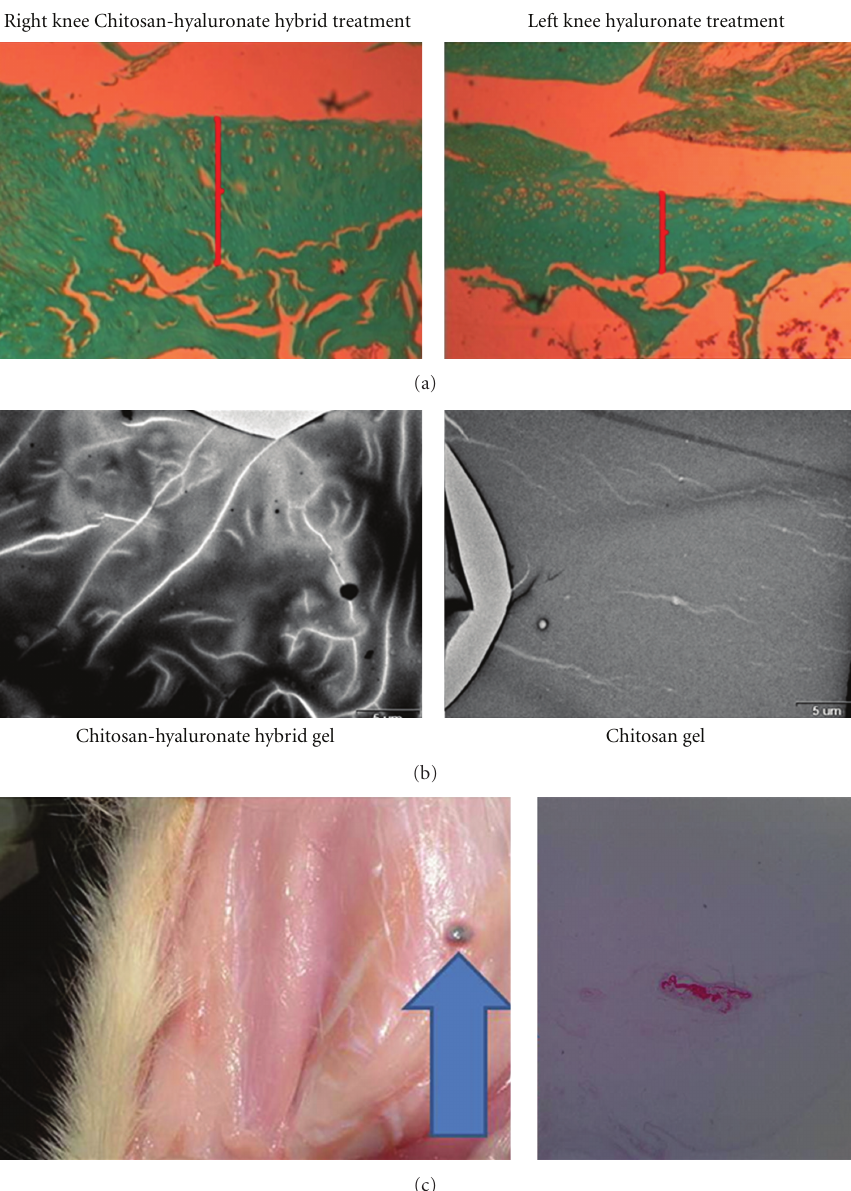
Figure 1: (a) rat knees following medial meniscectomy. Cartilage thickness is higher in the chitosan-hyaluronate-hybrid gel-treated knee than in the hyaluronate-treated knee. (b) environmental scanning electron microscopy seems to indicate that the hybrid gel has an internal structure. The authors hypothesize that the larger hyaluronate molecules (bright lines) appear to chaperon and organize the smaller chitosan molecules. (c) subcutaneous injection in rats does not evoke an inflammatory response macroscopically. The gel forms a discrete nodule (arrow head). This contrasts with the often observed intense inflammatory reaction previously reported with chitosan injection. The di ff erence seems to be related to the method of preparation of the gel and its specific components. Histologically, the gel nodule (red) is surrounded by minimal fibrous capsule without inflammatory cells aggregation (original magnification × 10, Safranin red